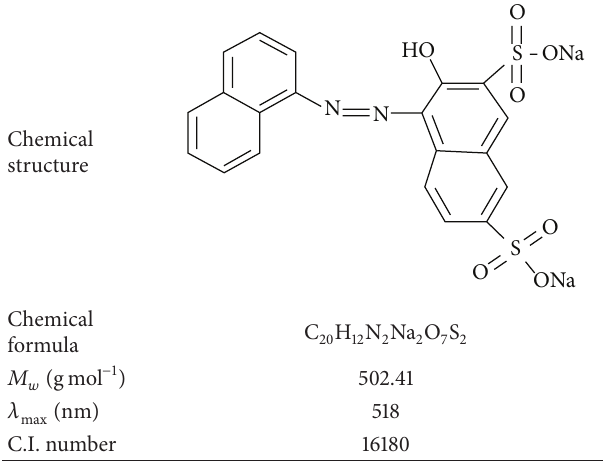
Table 1: Structure and characteristics of C.I. Acid Red 17